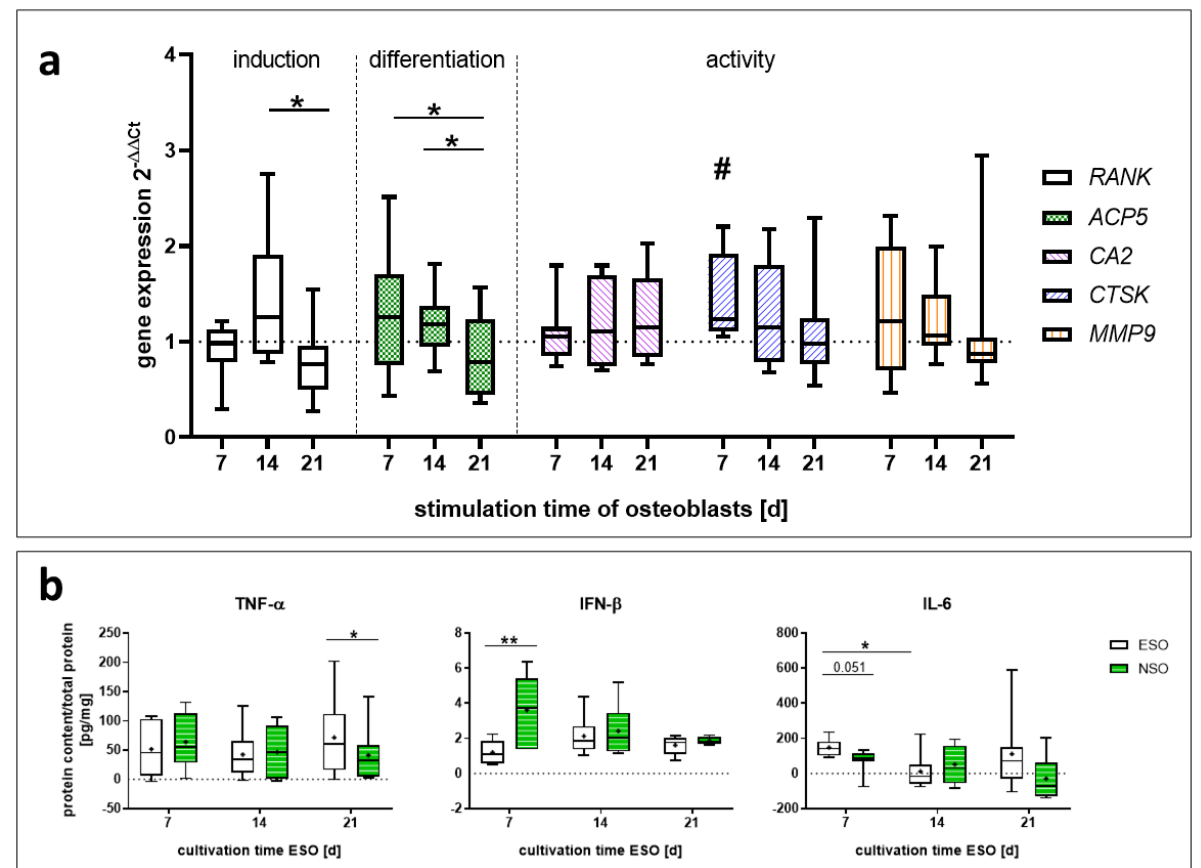
Figure 4. Gene expression and protein data of PBMCs after 48 h incubation with pooled supernatant of osteoblast (ESO) stimulated over 7, 14, and 21 d and without electric stimulation (NSO). ( a ) Gene expression data were related to the NSO using the 2 − ∆∆ Ct method. Boxplots are used to present the distribution of the total results with significant changes [n = 8]. Significant differences were determined using the two-way ANOVA with Tukey. # indicates significant differences between ESO and NSO cultivation: # p < 0.05. * indicates significant differences between stimulation time points: * p < 0.05. ( b ) The protein concentration was related to the total protein concentration of the supernatant of each sample. Afterward, the respective protein concentration from the control iwc was subtracted. Boxplots are used to present the distribution of the total results [n ≥ 6]. Significant differ- ences were determined using the two-way ANOVA with Tukey. * indicates significant differences: * p < 0.05, ** p <